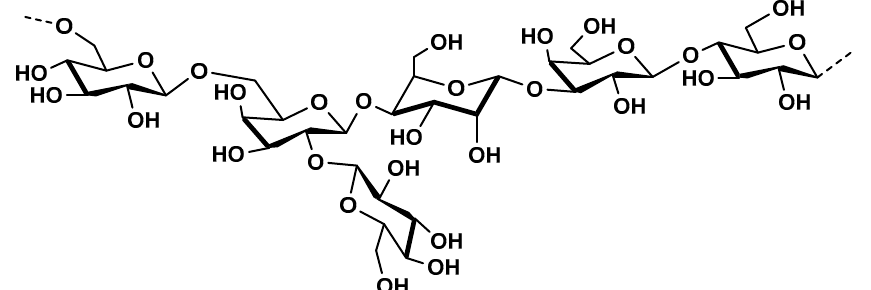
Figure 11. Chemical structure of Kefiran.